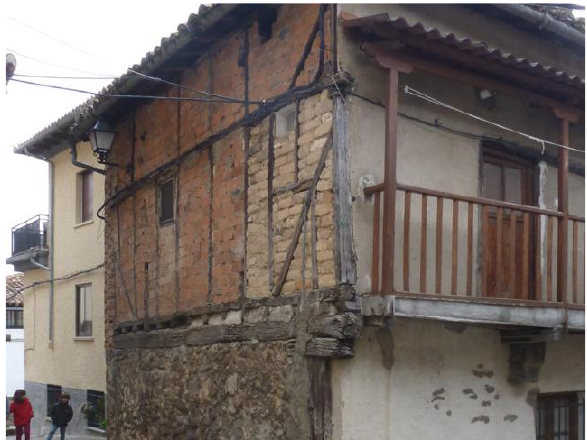
Figure 8. Building in Garganta la Olla (Cáceres), in which adobe infill has been substituted with industrial bricks.